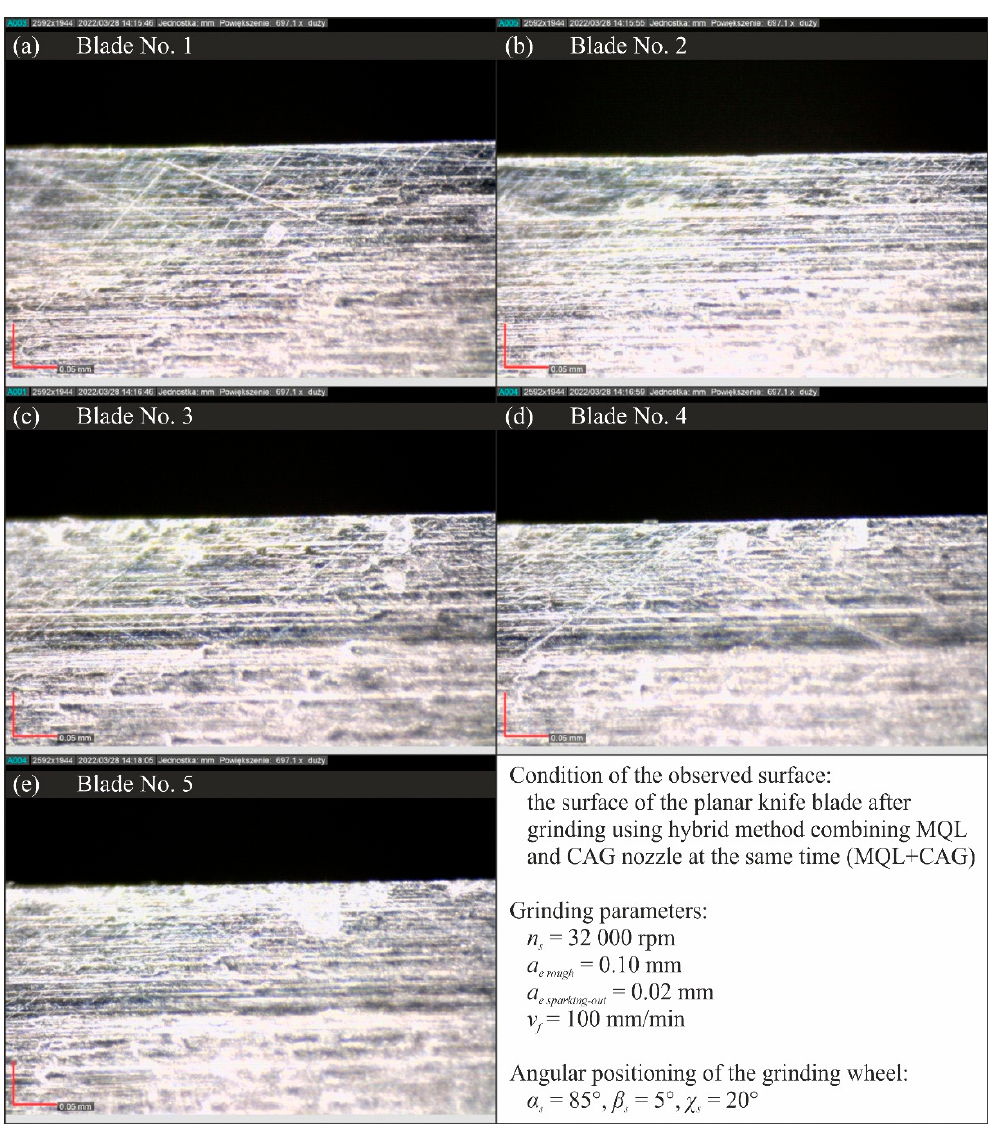
Figure 18. Microscopic views of the blade surfaces of five planar knives shaped using a hybrid method combining MQL and CAG nozzle at the same time (MQL + CAG) were recorded with a Dino-Lite Edge AM7515MT8A digital measuring microscope from AnMo Electronics Corp. (New Taipei City, Taiwan, China) at a magnification of approximately 700×: ( a ) blade No. 1; ( b ) blade No. 2; ( c ) blade No. 3; ( d ) blade No. 4; ( e ) blade No. 5.